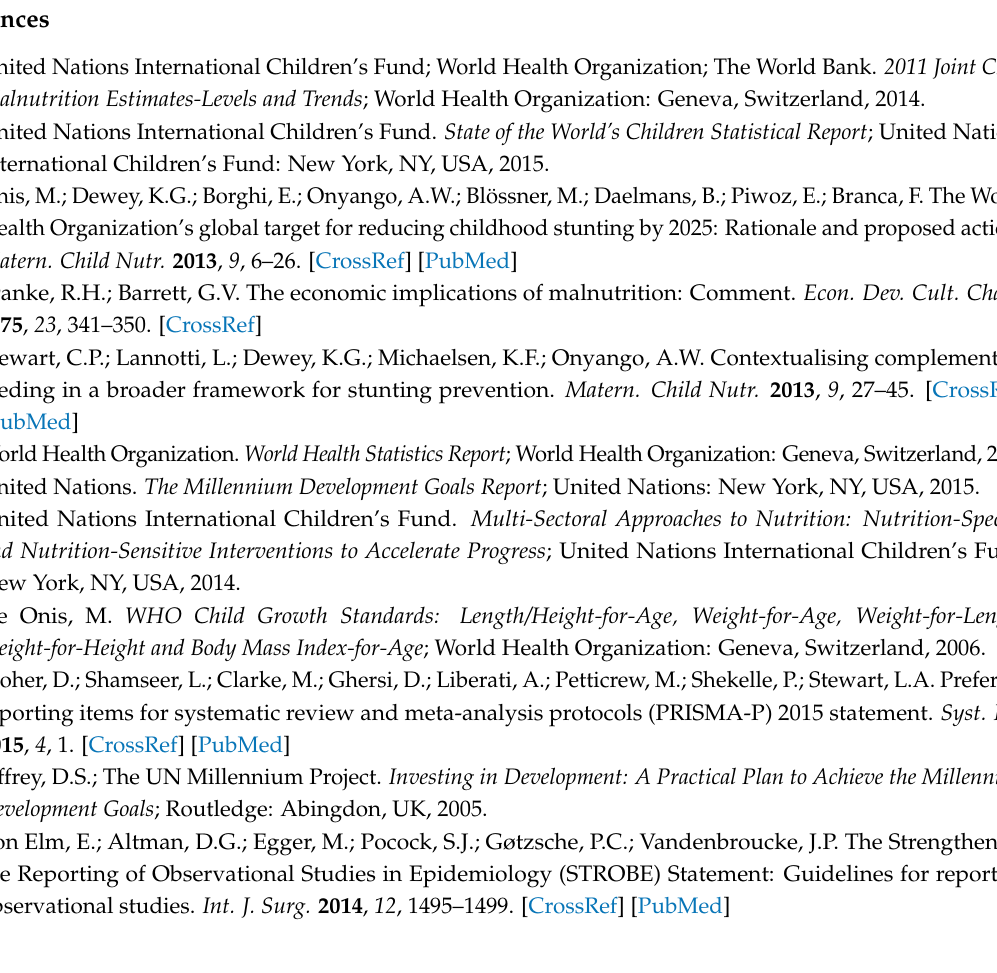
Table S1: Assessment tools used for the quality appraisal of the included studies, based on STROBE checklist; Table S2: Quality assessment of included